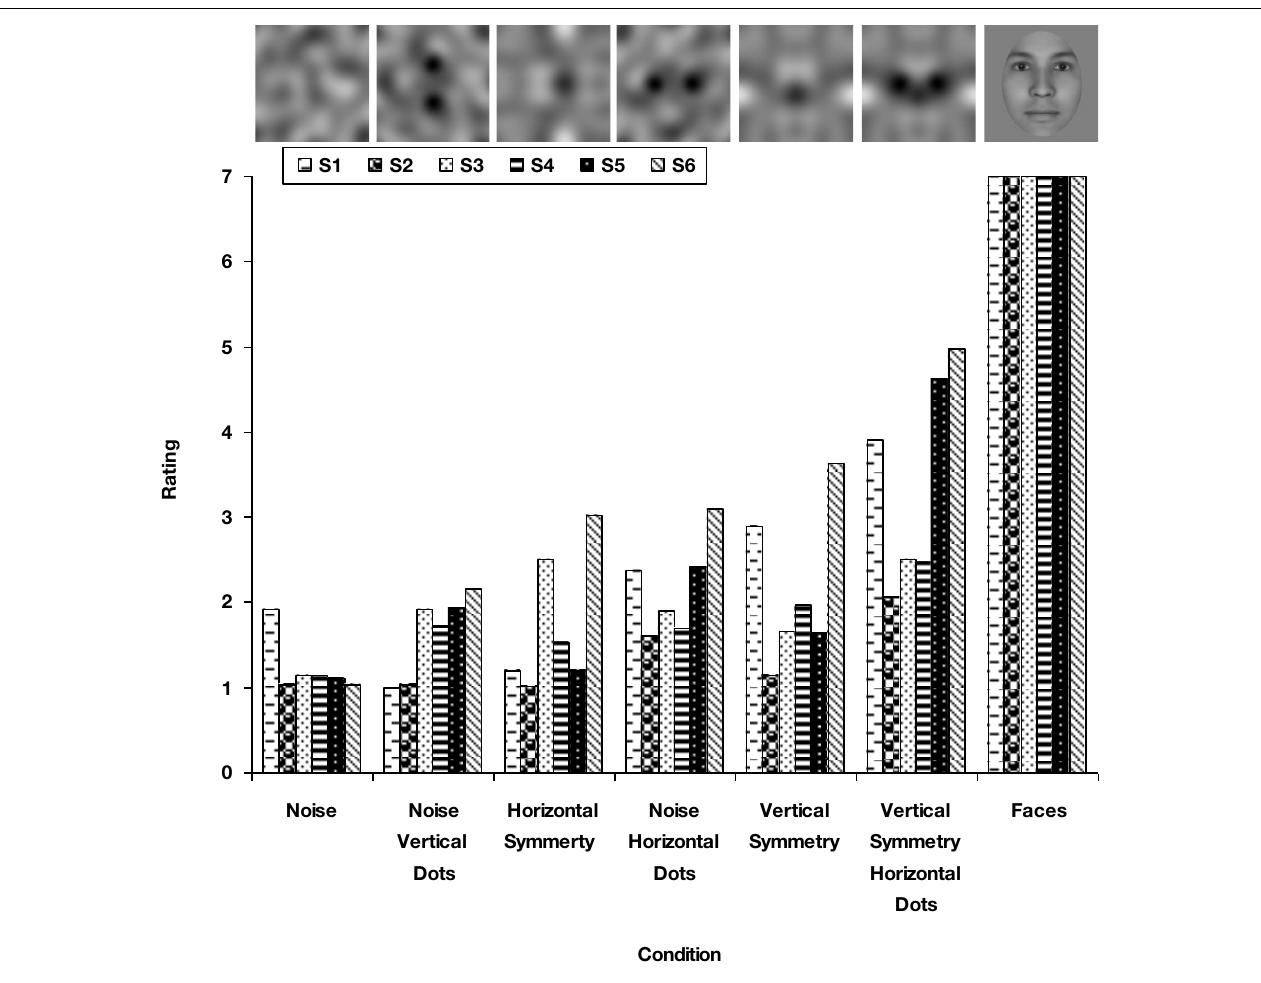
FIGURE 11 | Ratings of how “face-like” different versions of the noise appeared relative to a synthetic face image for six observers. A value of seven indicated that the image strongly resembled a real face. Noise image categories are ranked from left to right in increasing average ratings.